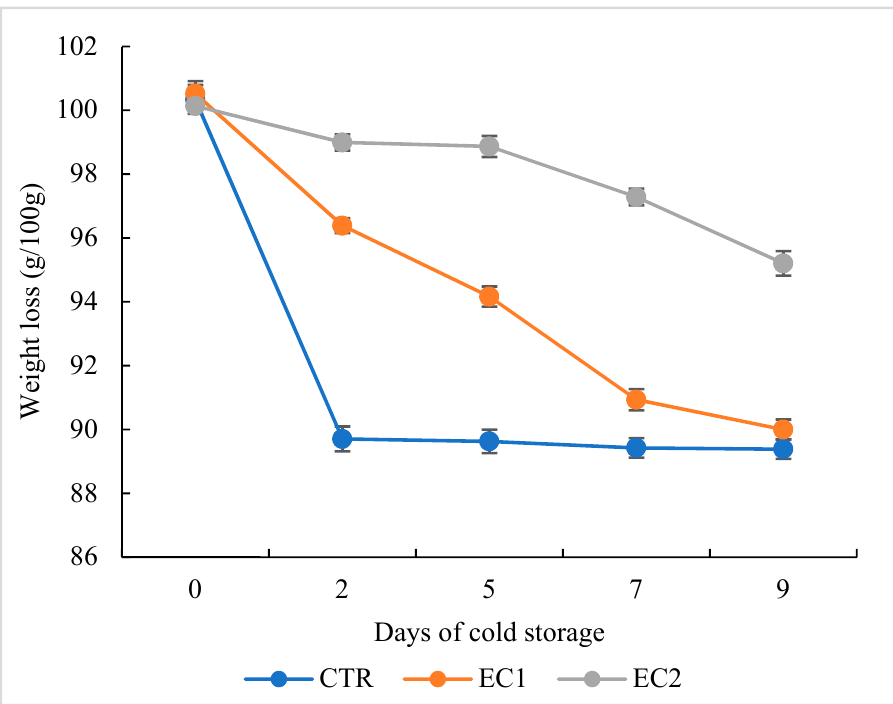
Figure 1. Variation in weight loss (WL–g/100 g) measured during 9 days of cold storage. Data correspond to the mean and bars indicate the standard deviation (SD) of three replicates (n = 3).